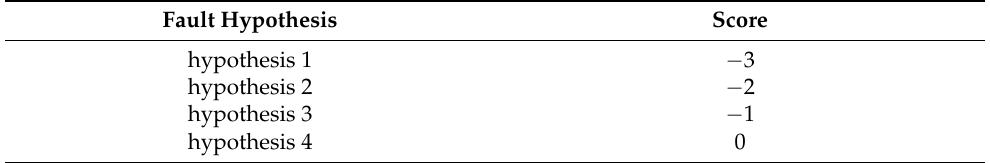
Table 2. The score of each fault